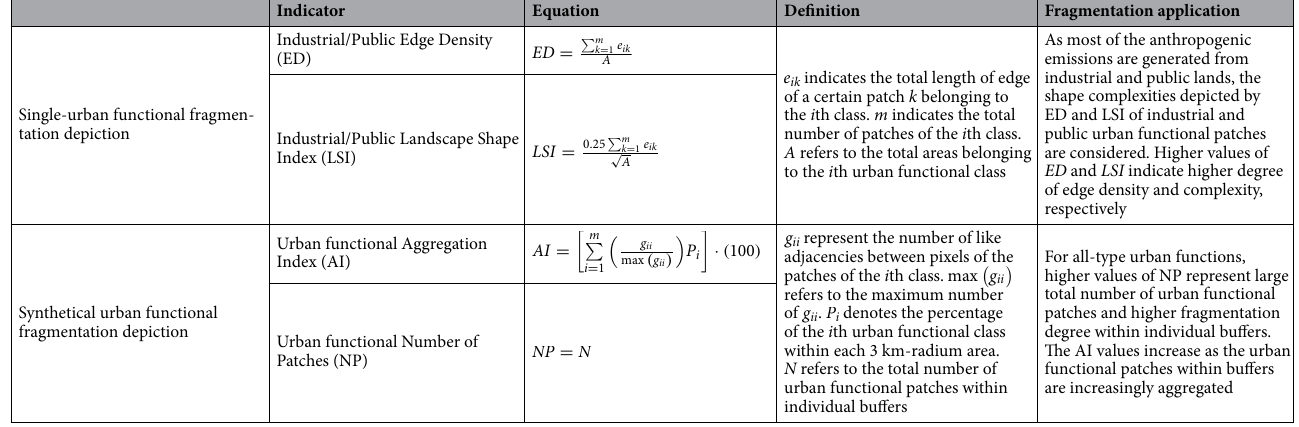
(Table 3): (1) UFB Model, including urban functional fragmentation characteristics before lockdowns; (2) UFD Model, including urban functional fragmentation characteristics during lockdowns; (3) UFCB Model, including both urban functional fragmentation characteristics and controlling variables before lockdowns; and (4) UFCD Model, including urban functional fragmentation characteristics and controlling variables during lockdowns. The proposal GAMs in UFB Model and UFD Model are defined as Eq. (4) and GAMs in UFCB Model and UFCD Model are defined as Eq. (5), respectively: